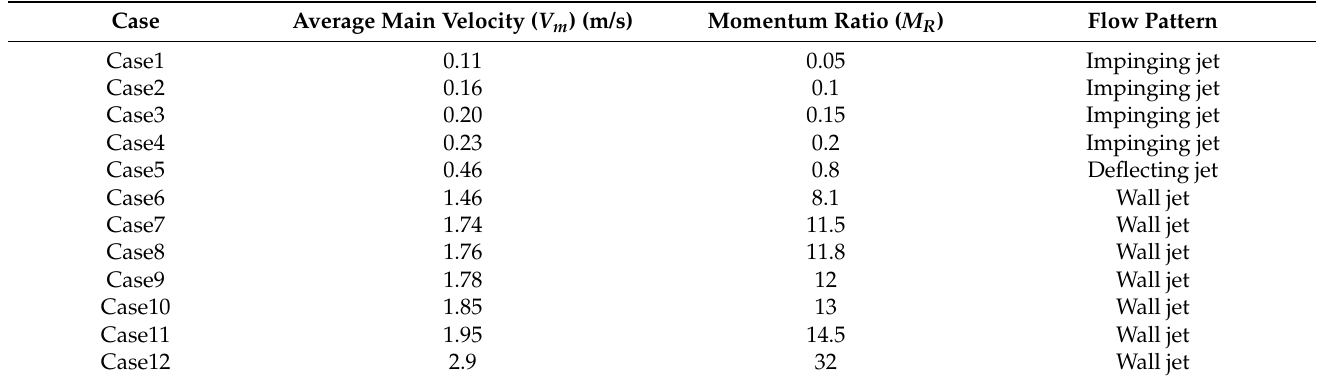
Table 4. Groups of simulations with different momentum ratios with average branch velocity V b = 1